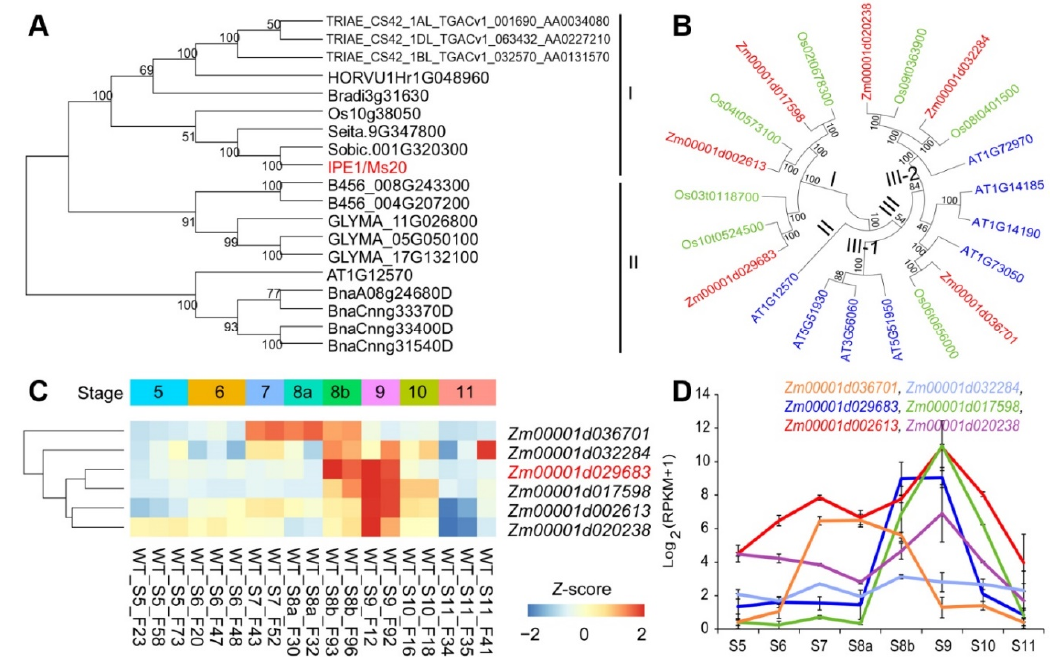
Figure 3. Phylogenetic analysis of ZmMs20 and its orthologs in different species and expression pattern analysis of ZmMs20 and its homologies in maize. ( A ) Phylogenetic analysis of ZmMs20 and its orthologs in different species. The analysis involved 19 amino acid sequences from Arabidopsis thaliana (At), Brassica napus (Bna, rape), Bradchypodium distachyon (Bradi, slender falsebrome), Hordeum vulgare (HORVU, barley), Gossypium raimondii (B, cotton), Glycine max (GLYMA, soybean), Oryza sativa (Os, rice), Setaria italica (Seita, millet), Sorghum bicolor (Sobic, sorghum), Triticum aestivum (TRIAE, wheat), and Zea mays ( IPE1 / Ms20 , maize). The numbers on the branches represent the bootstrap values of the phylogenetic tree. The 19 orthologs can be divided into two groups. Group I comprises nine proteins from monocots, and group II includes ten proteins from dicots. ( B ) Phylogenetic tree of GMC family members in Arabidopsis , rice, and maize. A neighbor-joining tree showed the evolutionary relationships among GMC members in Arabidopsis (At), rice (Os), and maize (Zm). The GMC family members are named according to maize GDB or Phytozome accession number. The numbers under the branches represent the bootstrap values. ( C ) Hierachical clustering of six GMC family genes in maize based on RNA-seq data of anthers during 8 anther developmental stages (S5 to S11). ( D ) Expression patterns of ZmMs20 and its five homologies in maize.